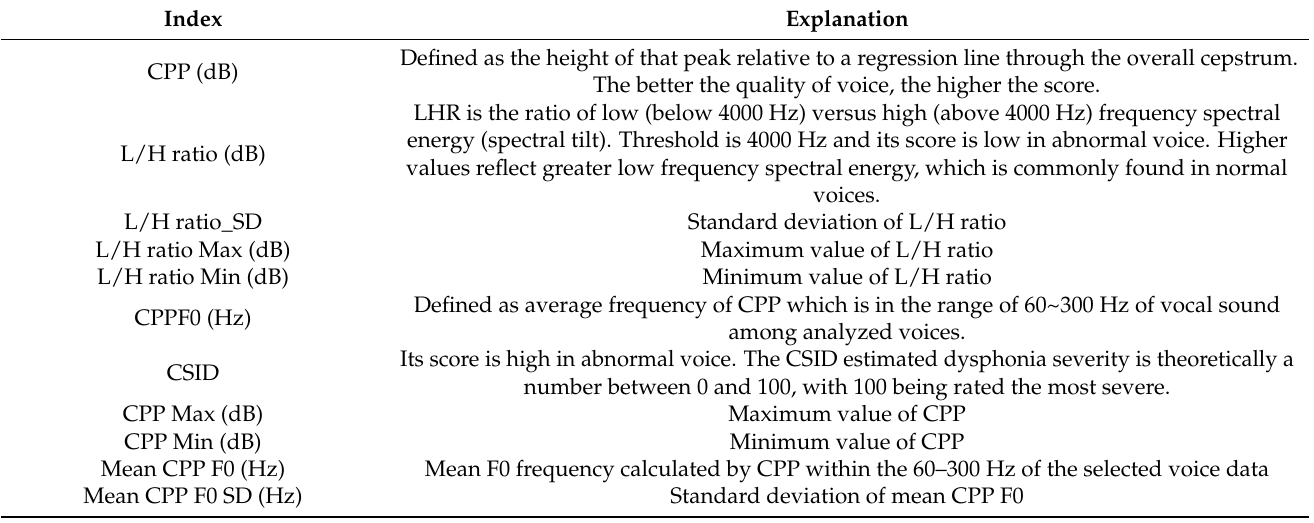
Table 1. The definitions of Cepstral and Spectral measures.